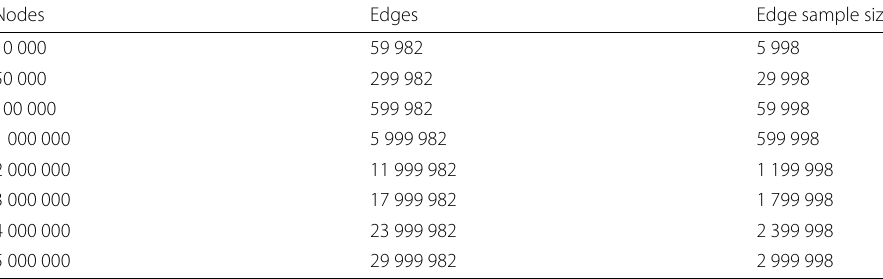
Nodes Edges Edge sample